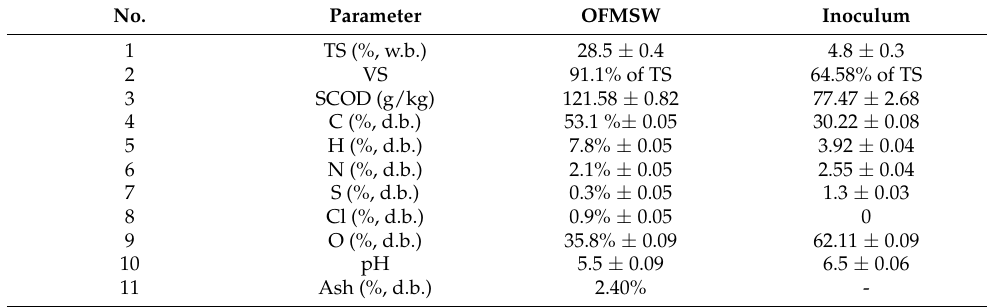
Table 1. Sample analysis.